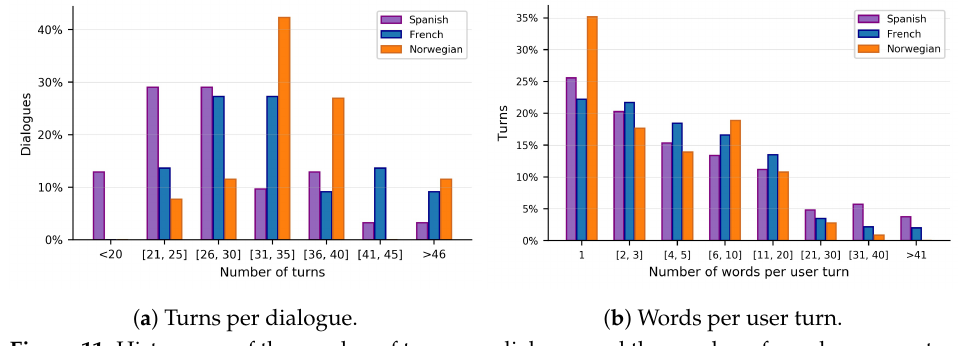
Figure 11. Histograms of the number of turns per dialogue and the number of words per user turn in the human evaluation of the final